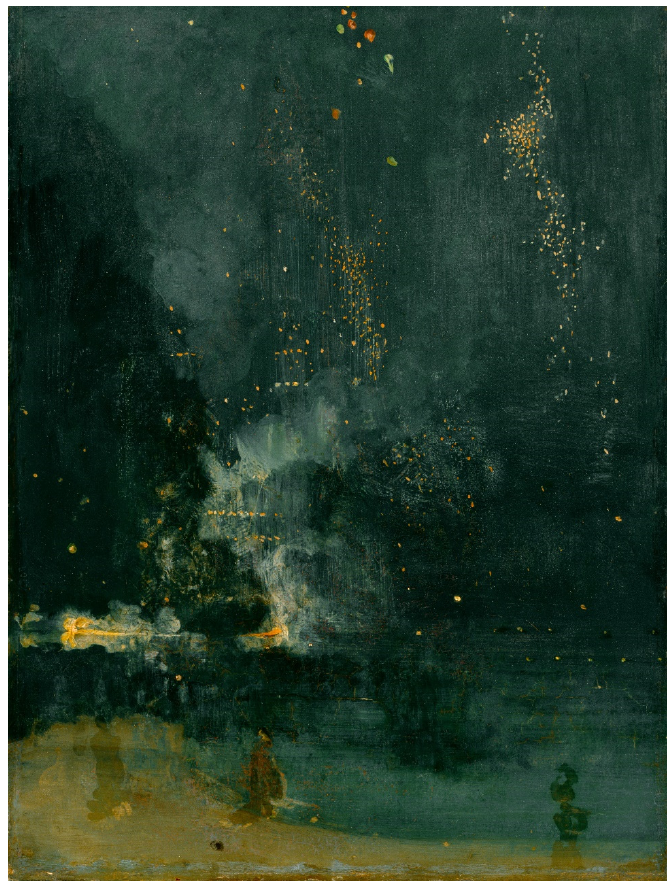
Figure 2. James McNeill Whistler, Nocturne in Black and Gold: The Falling Rocket , 1875, oil on panel, 60.2 × 46.7 cm. Detroit Institute of the Arts, Gift of Dexter M. Ferry, Jr., 46.309. Strategically, artists dramatized their hard work to Stephens: Alfred William Hunt wrote, ‘I am half killed with working at picture’. 34 John Inchbold explained that ‘some pictures cost me nearly two years in their work’. 35 Artists were discouraged when their works were rejected by the Academy and when their works were accepted but badly hung, high up (“skied”) which would obscure vital features of a work or its quality, failing